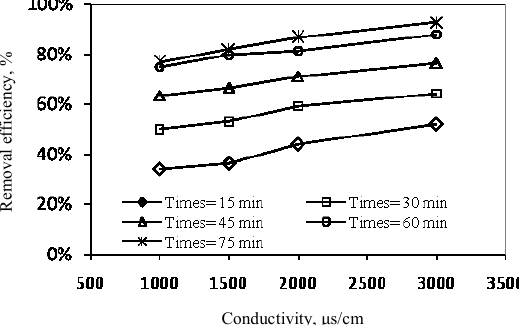
Figure 9. Effect of conductivity on the HA removal efficiency as a function of reaction time (initial concentration of HA: 20 mg L -1 , pH: 5, applied voltage: 50